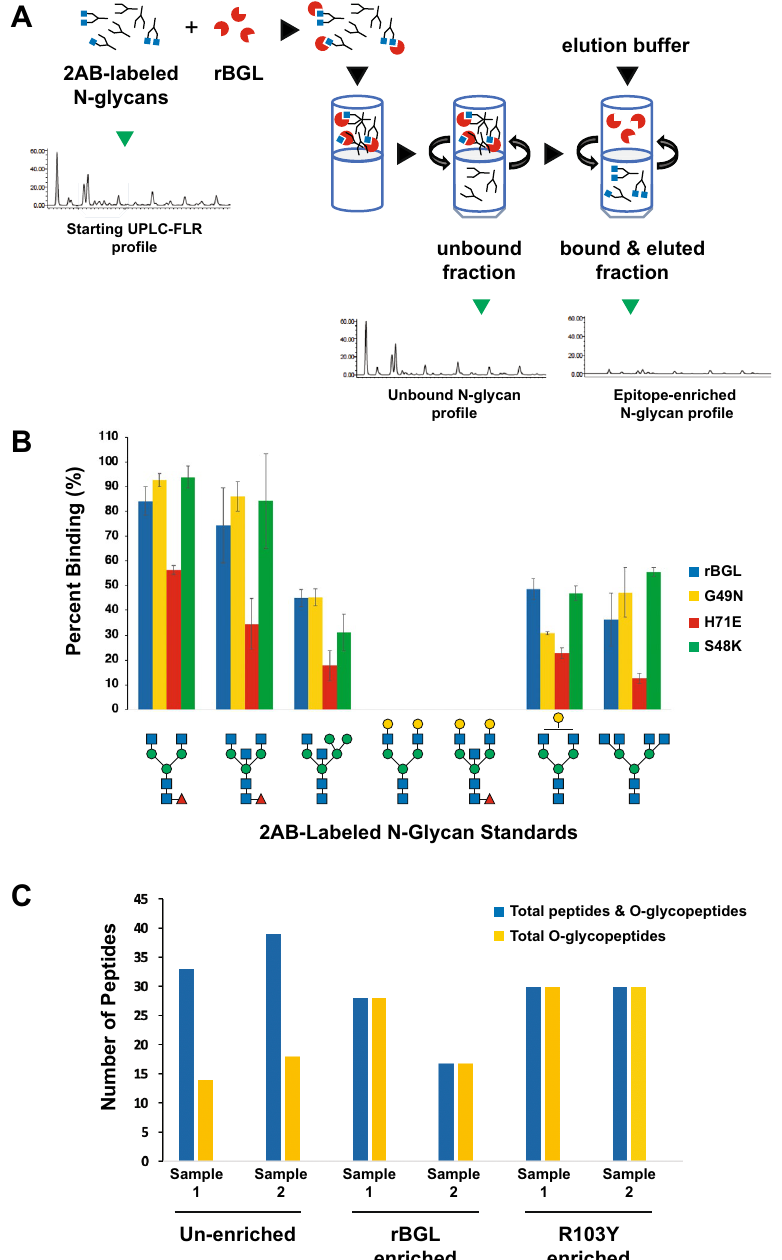
Figure 6. Use of rBGL and BGL mutants in analytical glycan enrichment schemes. ( A ) A schematic illustrating epitope-directed glycan enrichment (EDGE) sample preparation for UPLC-HILIC-FLR profiling 12 (drawing by S. Vainauskas and C. Taron). A mixture of 2AB-labeled N - glycans is mixed with a highly specific lectin (e.g., rBGL). The mixture is applied to a centrifugal filter (MWCO 10–30 kDa) and spun to separate lectin-bound or unbound N - glycans. An elution buffer dissociates the lectin–glycan complex and N - glycans possessing the desired epitope (e.g., terminal GlcNAc) are recovered by centrifugation then subjected to UPLC-HILIC- FLR analysis. ( B ) EDGE UPLC-HILIC-FLR profiling of several 2AB-labeled N-glycan standards. Percent glycan binding (calculated as described in “Materials and methods”) is shown for rBGL and mutants G49N, H71E, and S48K. ( C ) Enrichment of O-glycosylated peptides/peptiforms from Pronase digested bovine fetuin before and after enrichment with rBGL or R103Y. Sample 1 and 2 represent replicate samples that were each separately digested with Pronase and subjected to lectin enrichment. Blue bars represent the total number of peptides identified (unglycosylated peptides and O-glycopeptides). Yellow bars represent the number of unique O-glycopeptides/peptiforms identified in each sample (see Supplementary Table 7 for the O-glycan structures